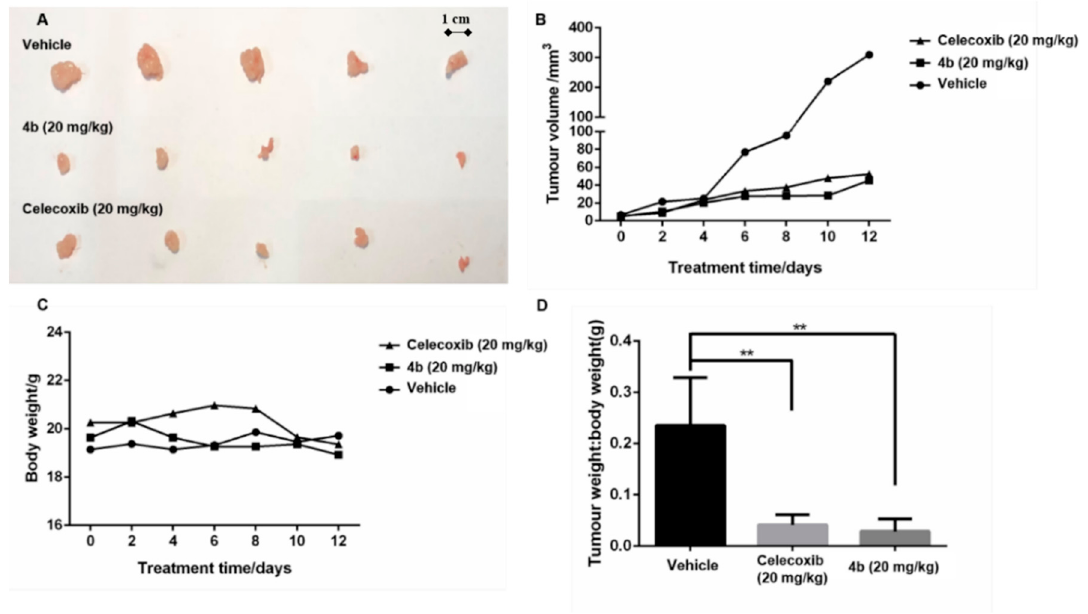
Figure 5. Antitumor activity of compound 4b in SW620 xenografts tumor model. ( A ) Physical photos of each group of tumor resection. ( B ) The tumor volume changes after drug administration with Celecoxib (20 mg/kg), 4b (20 mg/kg) or vehicle. Data were measured every other day by using a Vernier caliper and calculated as 0.5 × length × width 2 (mm 3 ). ( C ) Relative weight changes were monitored and recorded every two days in each group. ( D ) Average ratio of tumor weight to body weight from each group; ** p < 0.01.